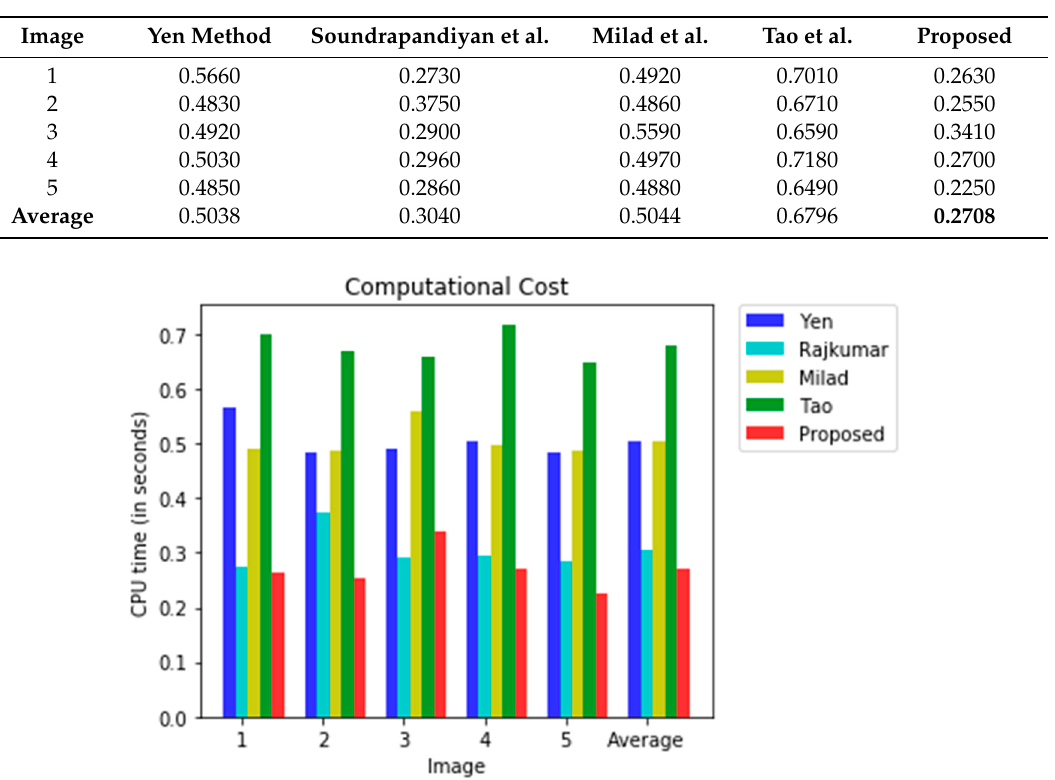
Figure 7. Comparison of the c omputational cost for the five methods.